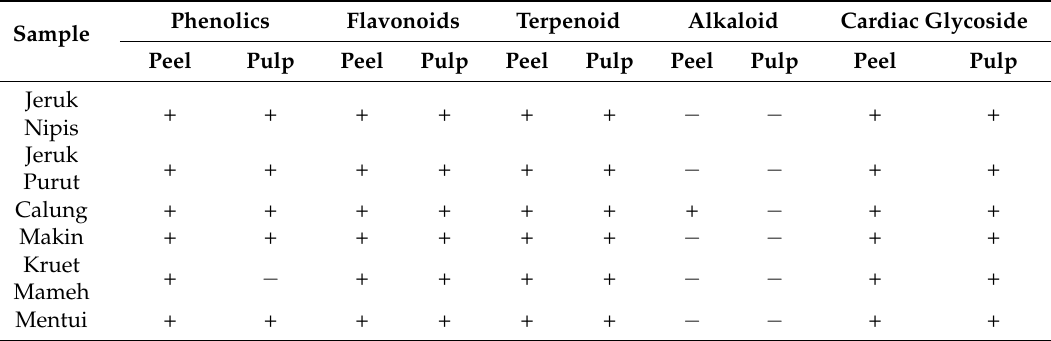
Table 3. Phytochemical test results of MeOH/THF extracts of citrus